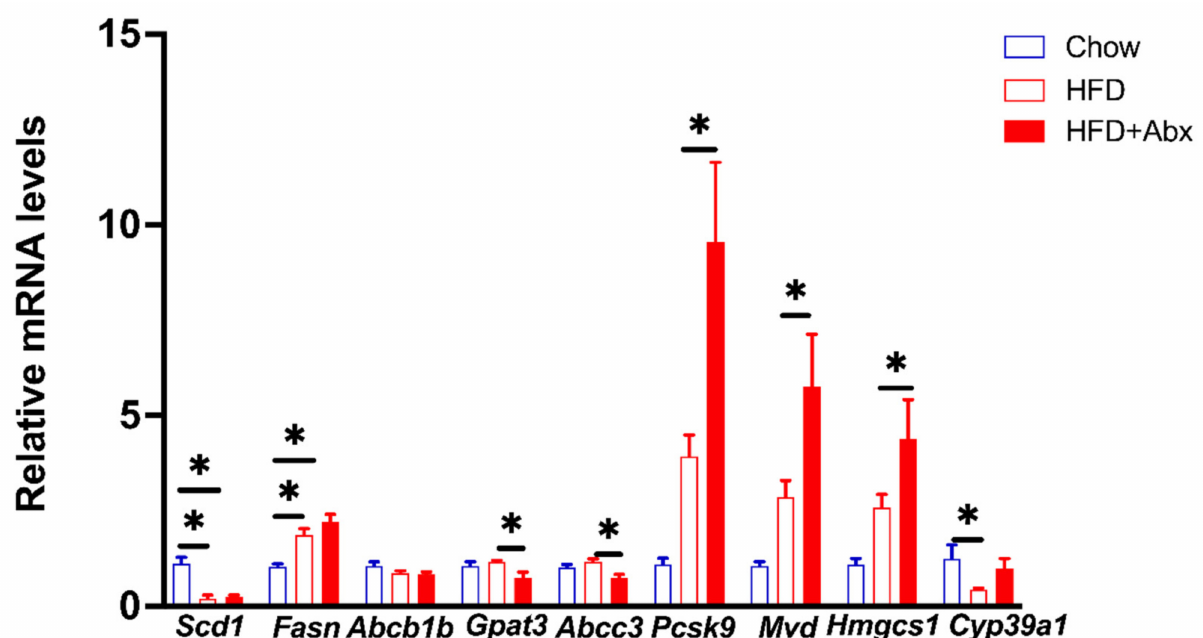
Figure 9. qRT-PCR validation of the differentially expressed genes between Chow, HFD, and HFD+Abx groups. Data were expressed as the mean ± SEM. * p <